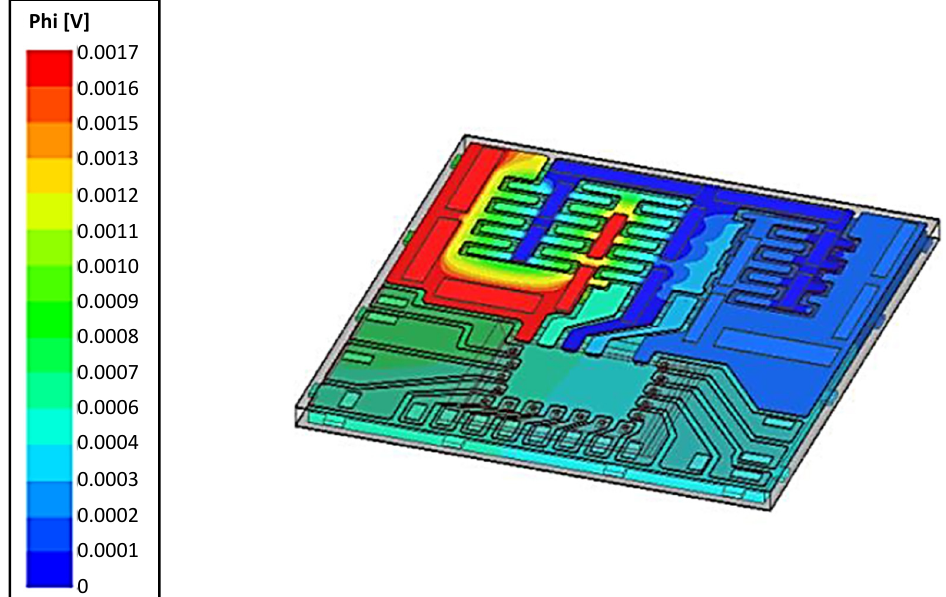
Figure 5. Voltage map, with a current equal to 90 A at 500 kHz as input.